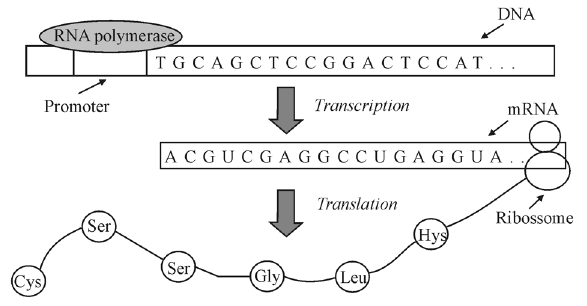
Figure 1 - Gene expression process. Figure 2 - Splicing in mRNA